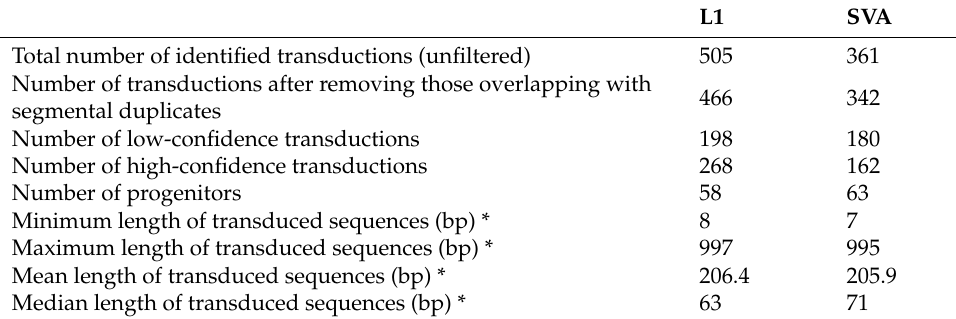
Table 3. Overview of identified 3 (cid:48) transduction variants.